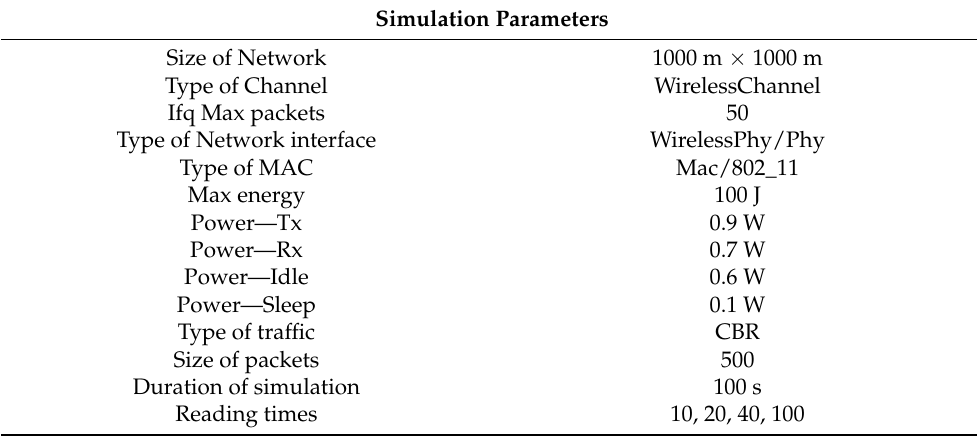
Table 8. Common parameters for all the simulations.